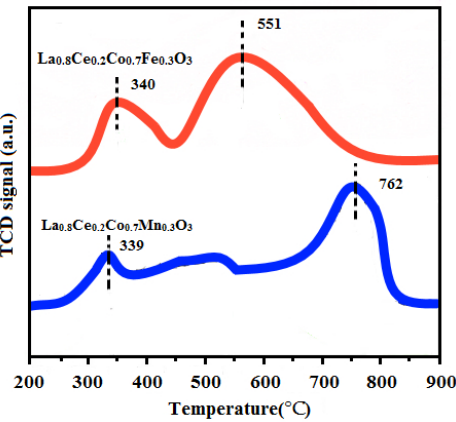
( d ) Figure 14. Purification efficiency curve of catalyst when B site was doped with manganese ions: ( a ) NO X ; ( b ) PM; ( c ) CO; and ( d ) HC. The H 2 -TPR experiments were conducted on a TPDRO instrument (TP-5080, Xian- quan, Tianjin, China) using a thermal conductivity detector (TCD). H 2 -TPR techniques were used to measure the reducibility of La 0.8 Ce 0.2 Co 0.7 Fe 0.3 O 3 and La 0.8 Ce 0.2 Co 0.7 Mn 0.3 O 3 catalyst samples. The corresponding H 2 -TPR profiles are presented in Figure 15. Both of the samples exhibit two